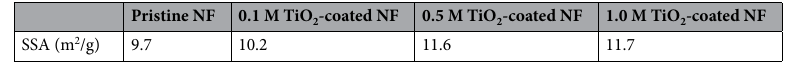
Table 1. SSA of YSZ/silica (pristine) and TiO 2 -coated YSZ/silica